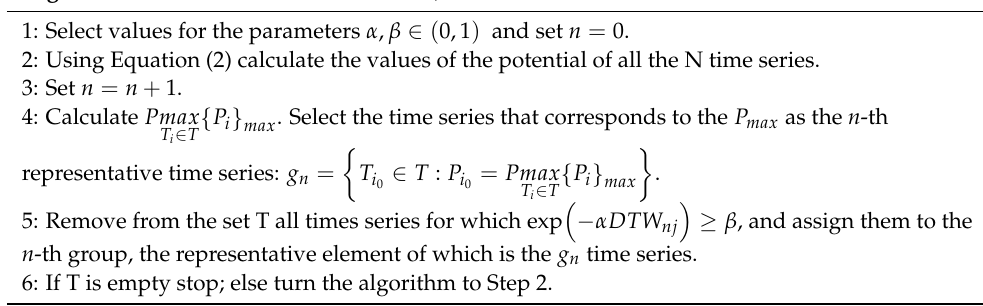
Algorithm 1: Data Reduction Process